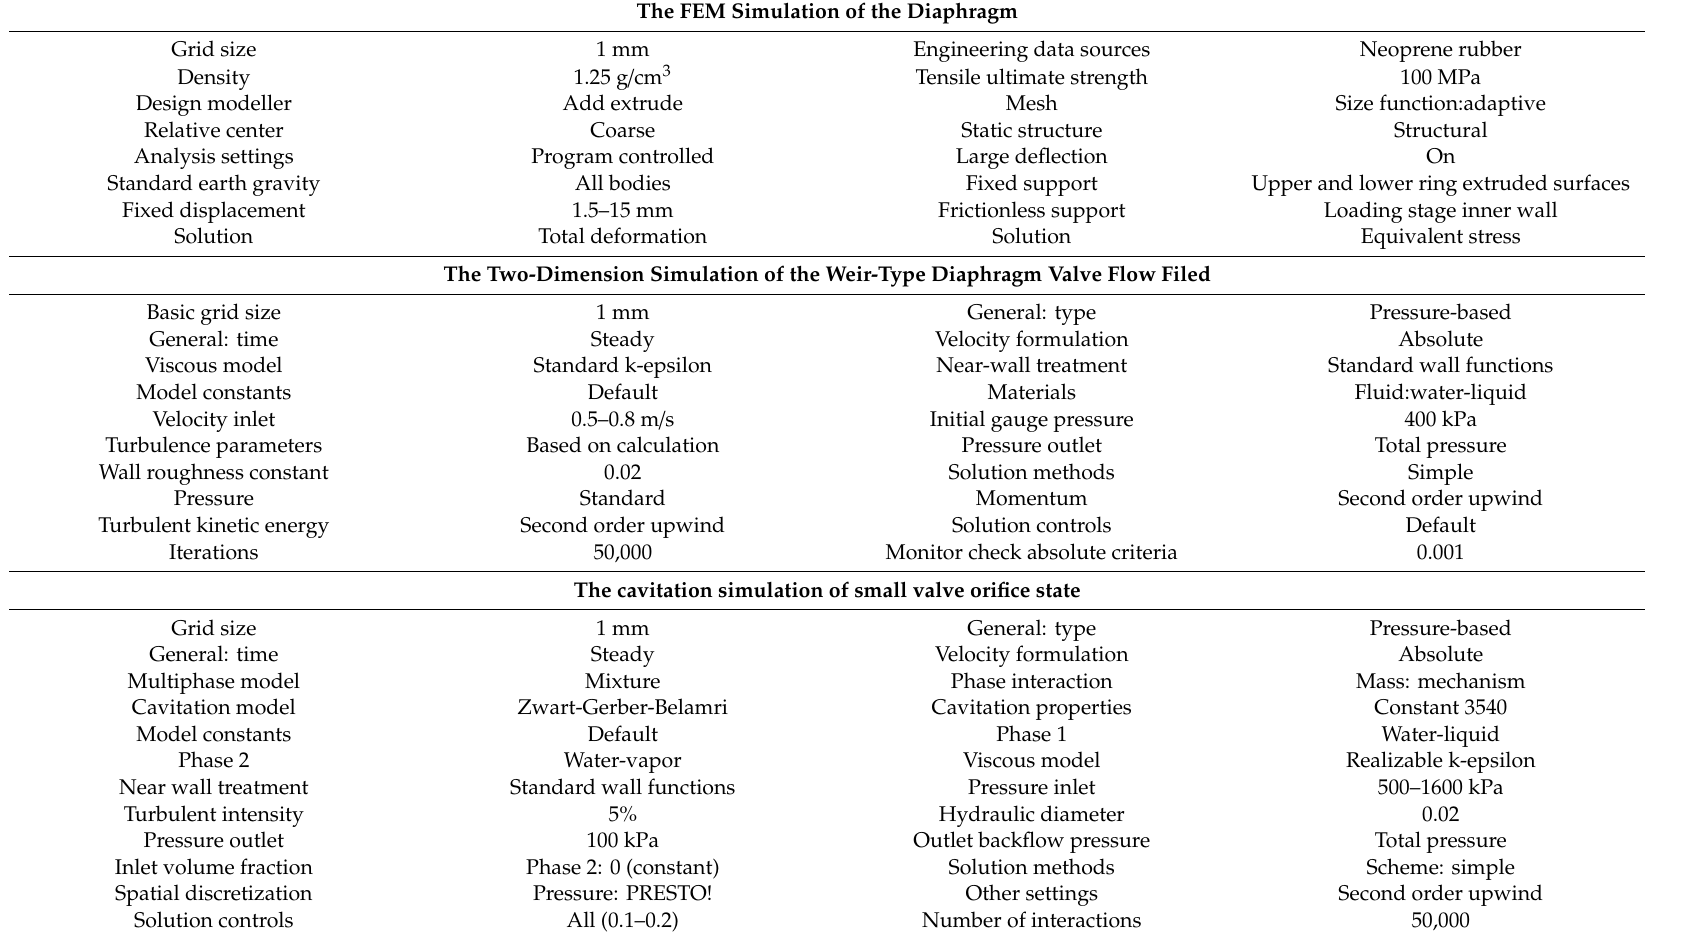
Table A1. Simulation settings and